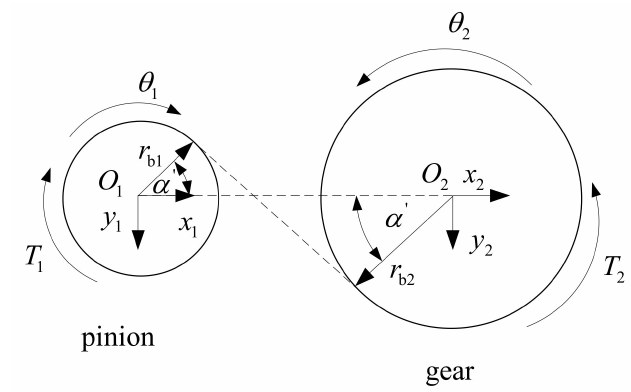
Figure 4. Relative displacement of gear